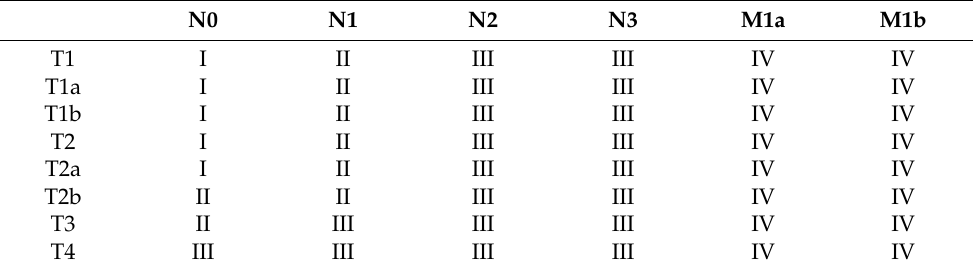
Table 1. Stage according to The TNM (Tumor size, lymph Node metastasis, distant Metastasis) Staging